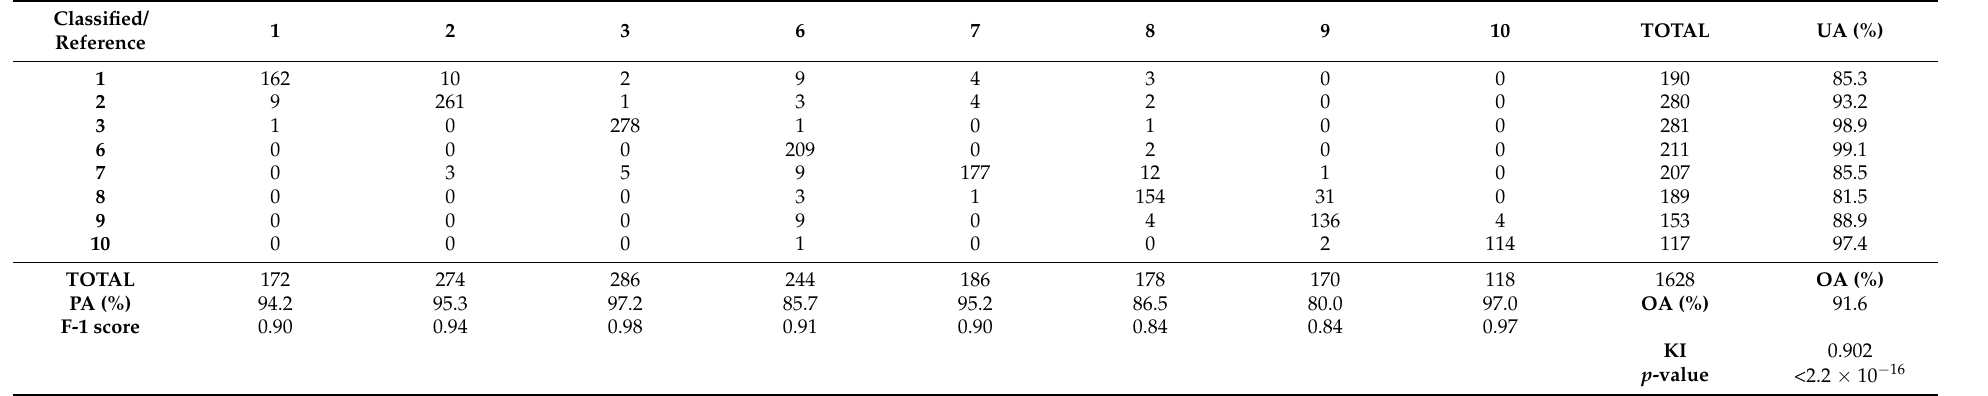
Table 9. Confusion matrix of the cross verification performed for the classification produced at 20 m to decide the optimal resolution for producing regional land cover maps. Obtained metrics: Users Accuracy (UA), Producer’s Accuracy (PA) and the Kappa Index (KI). Eucalyptus spp. (1), Conifers (2), Broadleaves (3), Crops and pastures (6), Shrubs (7), Bare soil (8), Anthropogenic areas (9) and Water (10).